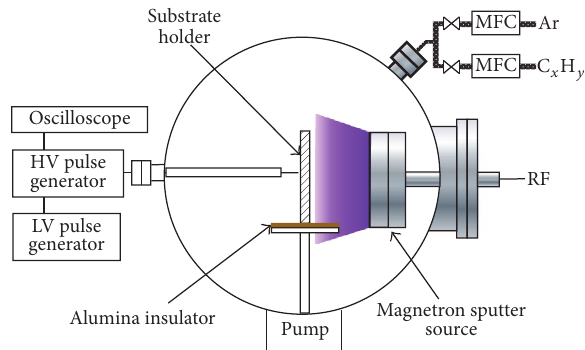
Figure 1: Schematic diagram of the magnetron PSII system. MFC = mass flow controller.